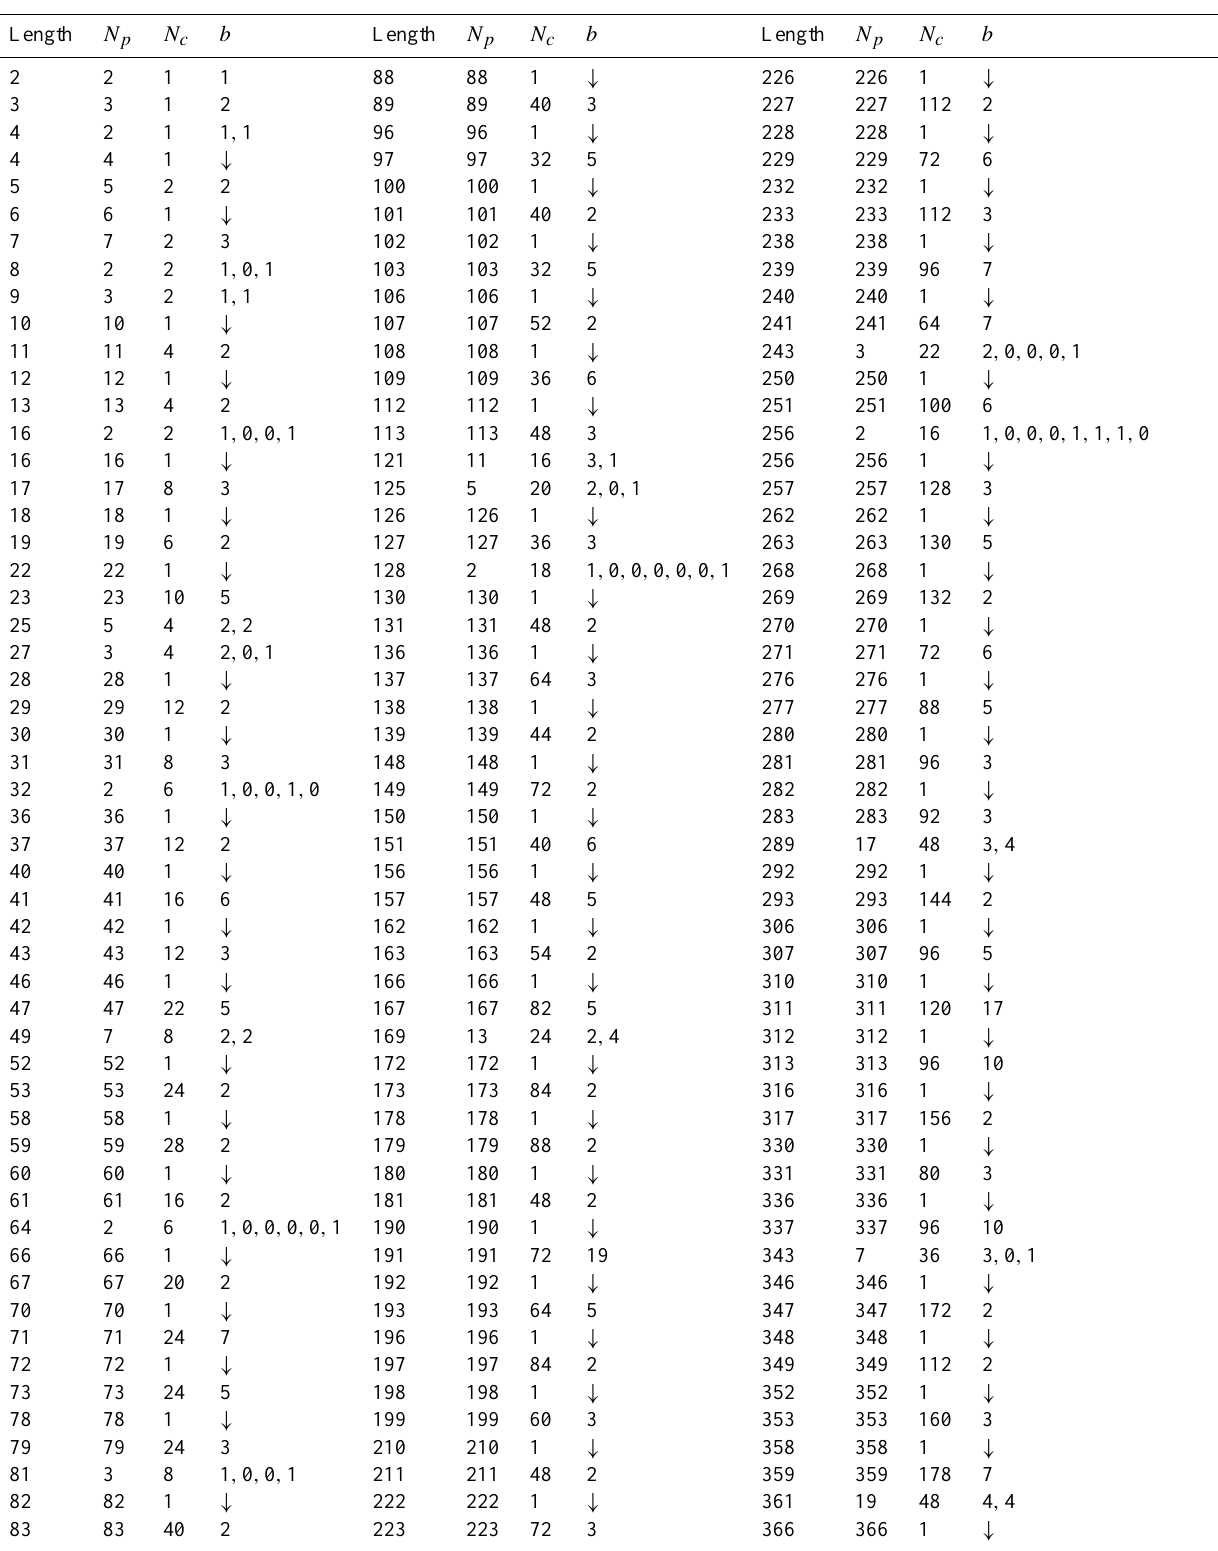
Table 1. Alternating codes with lengths up to 366. The number of phases is denoted by N p , the number of different code sets N c and the generator coefficients are denoted by b . Only one generator b is given for each code length. The ( p –1)-nary codes are generated from the next consecutive